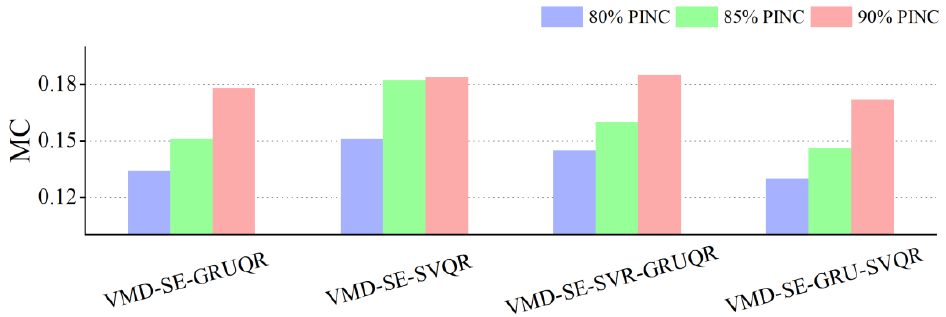
Figure 12. MC averages of some models at three confidence levels.